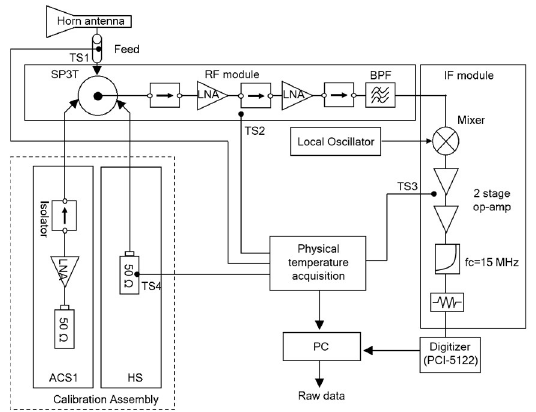
Figure 4. Block diagram of the developed L-band radiometer.